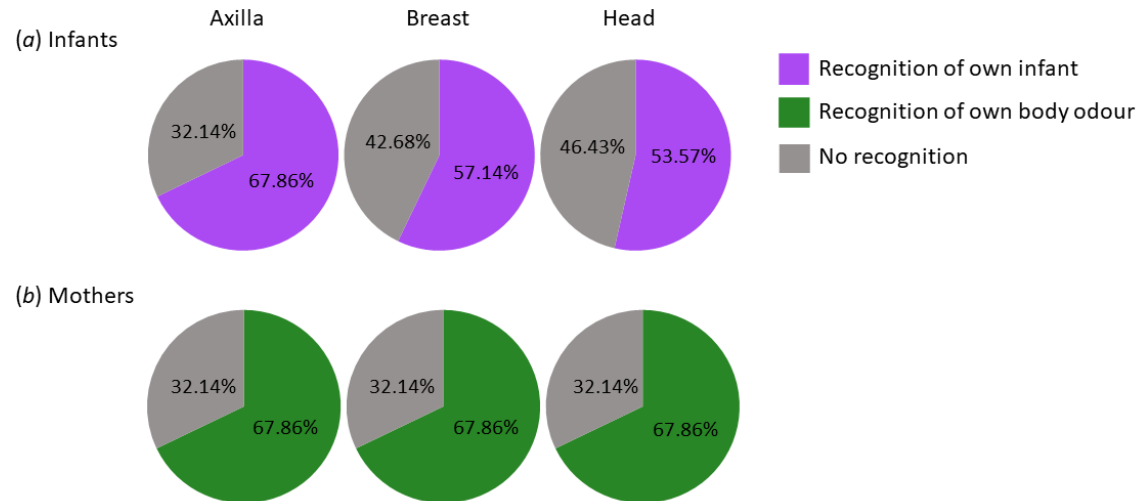
Figure 3. Recognition performance of the familiar odour. ( a ) Infantile odours. One’s own infant was to be chosen out of 3 body odour samples for each axilla, breast, and head of infants aged up to 12 months. ( b ) Maternal odours. Participants had to choose their own odour out of three samples from adult mothers for each axilla, breast, and head. Recognition of own infant/recognition of own body odour = the familiar odour was correctly identified. No recognition = participants mistook an unfamiliar odour for their own/their own infant’s